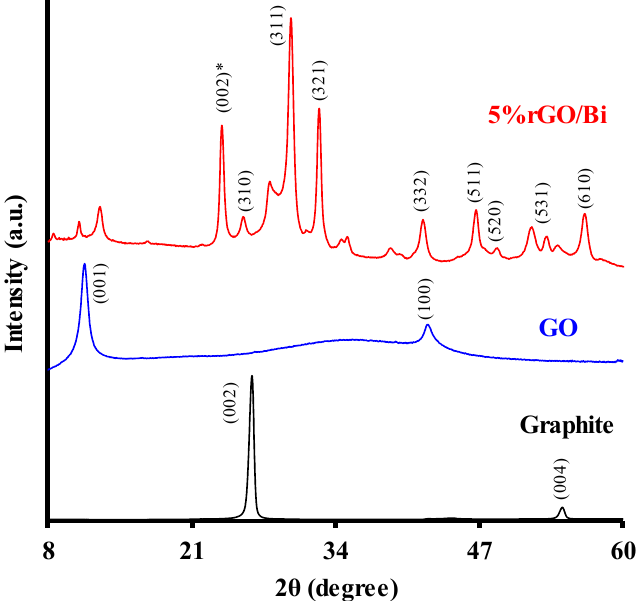
Figure 4. XRD patterns of graphite, graphene oxide, and 5%rGO/Bi.